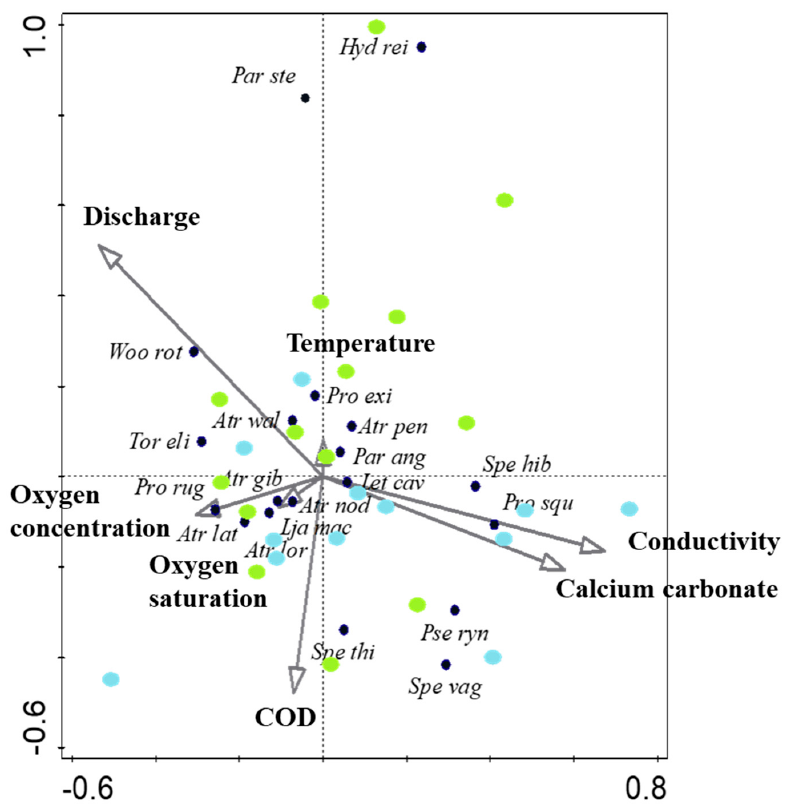
Figure 2. Canonical correspondence analysis (CCA) ordination of water mite samples, species and environmental water properties. Water mite taxa are marked with black dots, samples from limnocrenes with green dots, samples from rheocrenes with blue dots and environmental water properties with arrows. Arrow length on the ordination indicates the relative importance of the explanatory variables (physico-chemical water properties), and their direction relative to each other and to the sites indicates positive or negative correlations. Abbreviations: COD = Chemical oxygen demand; Atractides gibberipalpis = Atr gib; A. latipalpis = Atr lat; A. loricatus = Atr lor; A. nodipalpis = Atr nod; A. pennatus = Atr pen; A. walteri = Atr wal; Hydrodroma reinhardi = Hyd rei; Lethaxona cavifrons = Let cav; Ljania macilenta = Lja mac; Partnunia angusta = Par ang; Partnunia steinmanni = Par ste; Protzia eximia = Pro exi; Protzia squamosa = Pro squ ; Protzia rugosa = Pro rug; Pseudotorrenticola rhynchota = Pse ryn; Sperchon hibernicus = Spe hib; S. vaginosus = Spe vag; S. thienemanni = Spe thi; Torrenticola elliptica = Tor eli; Woolastookia rotundifrons = Woo rot. Oxygen concentration values ( t -test, F = 1.18; p < 0.01) and discharge levels (F = 7.52; p < 0.001) were significantly higher in limnocrenes, whereas conductivity (F = 3.26; p < 0.05) and values of dissolved CaCO 3 (F = 5.14; p < 0.01) were significantly higher in rheocrenes. 3.2. Water Mite Diversity in Spring Morphotypes Water mite abundances were found not to differ significantly between spring morphotypes (Figure 3). However, water mite species richness (F = 1.517; p < 0.05) and local diversity (Shannon index; F = 1.257; p < 0.05) were found to be significantly higher in rheocrenes when compared to limnocrenes.